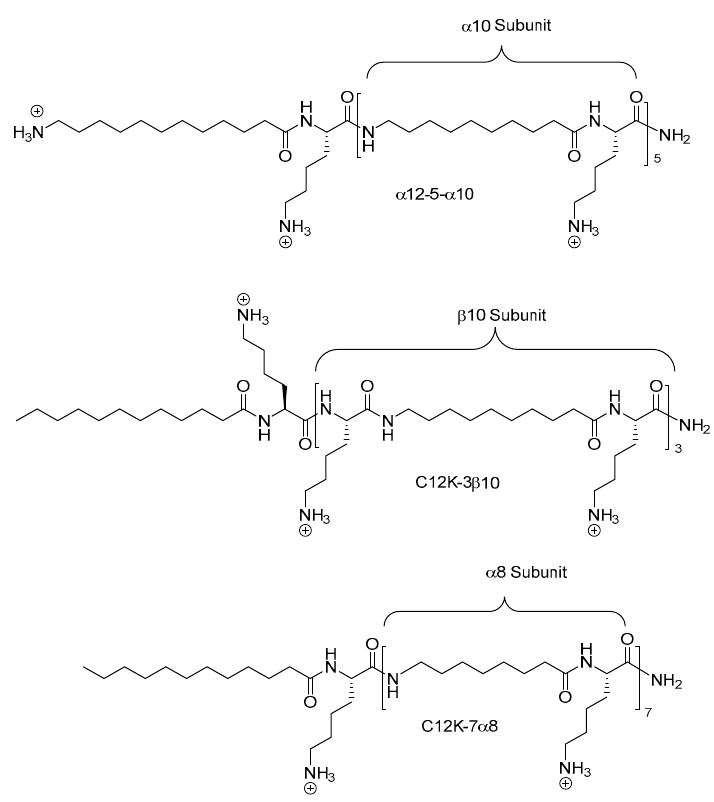
Figure 14. Representative OAK structures.